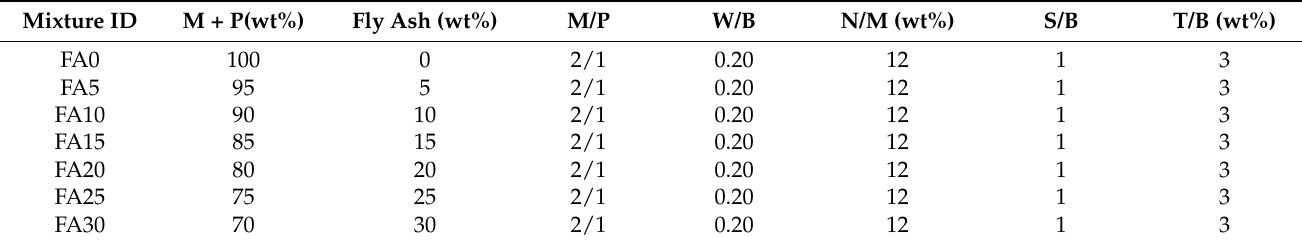
Table 2. Mixure of MPC mortars.